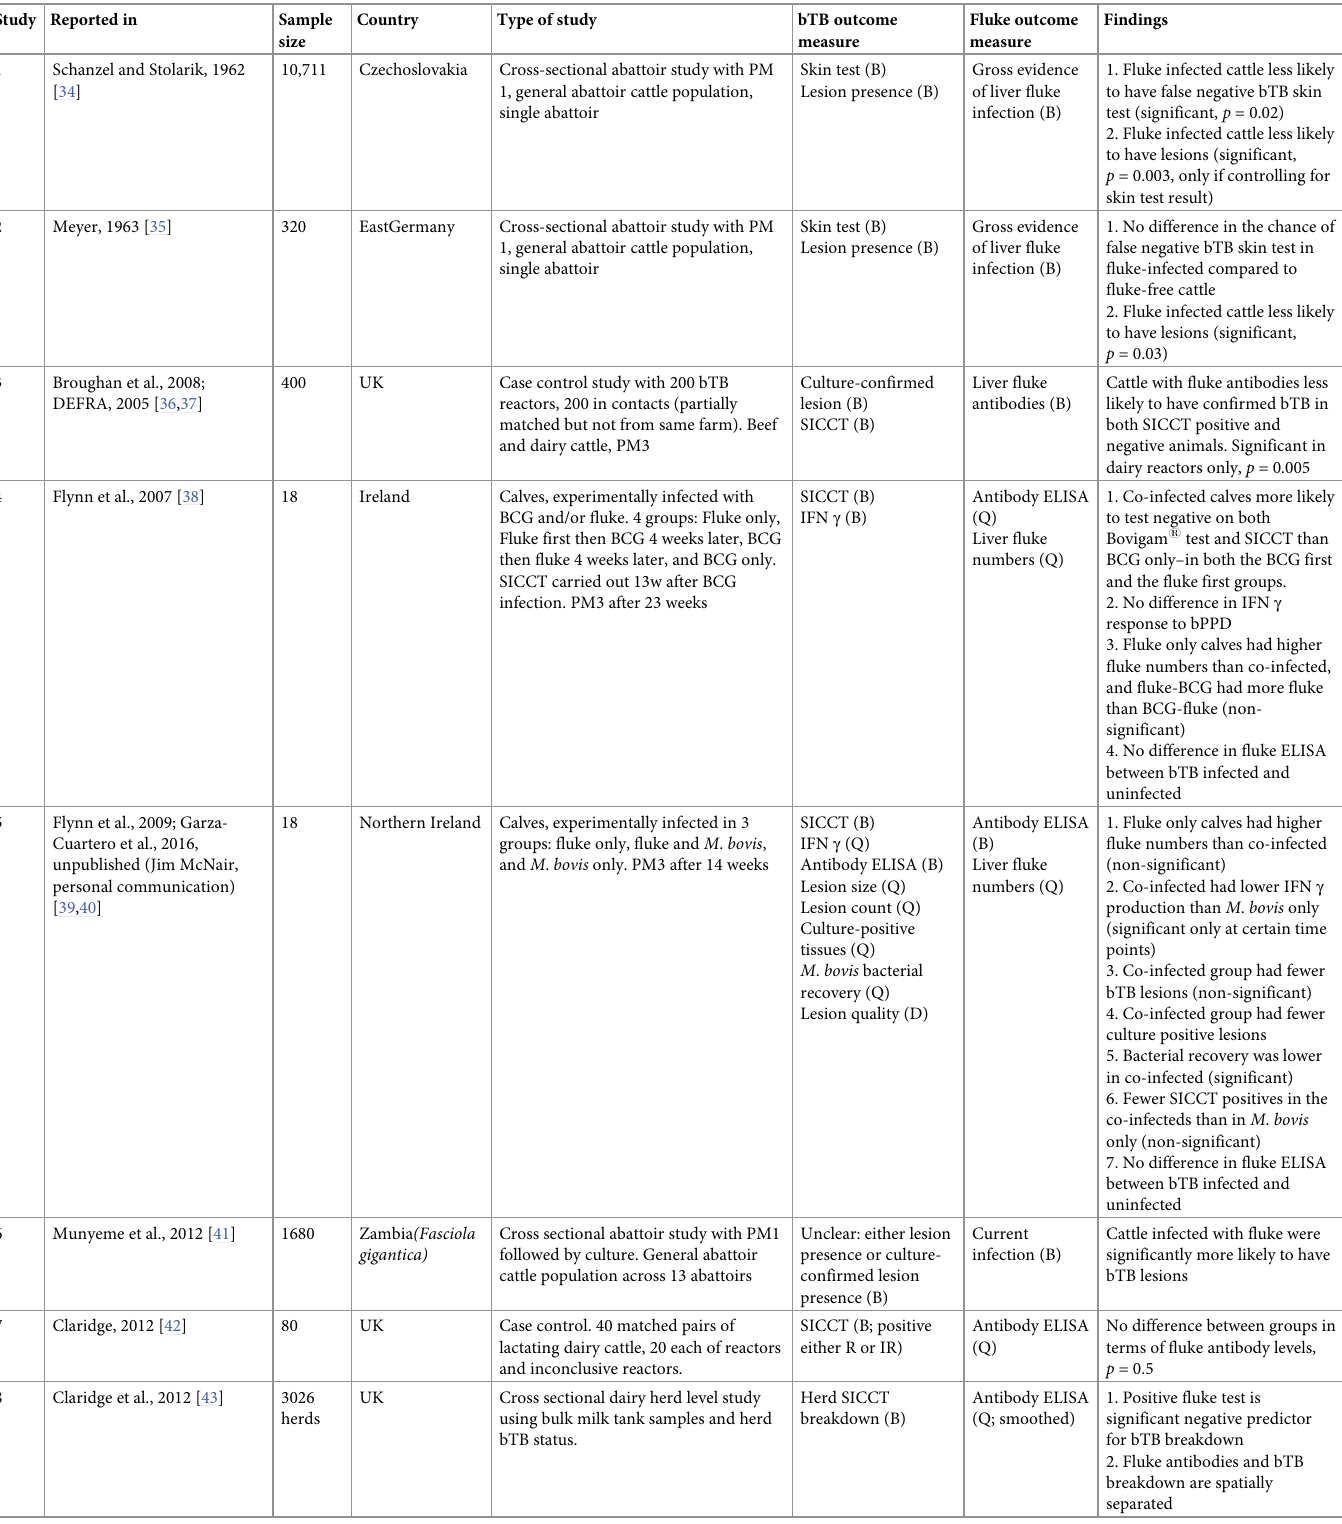
Table 1. A summary of the studies meeting the criteria for inclusion in the systematic review of bovine tuberculosis (bTB) and liver fluke. Study Reported